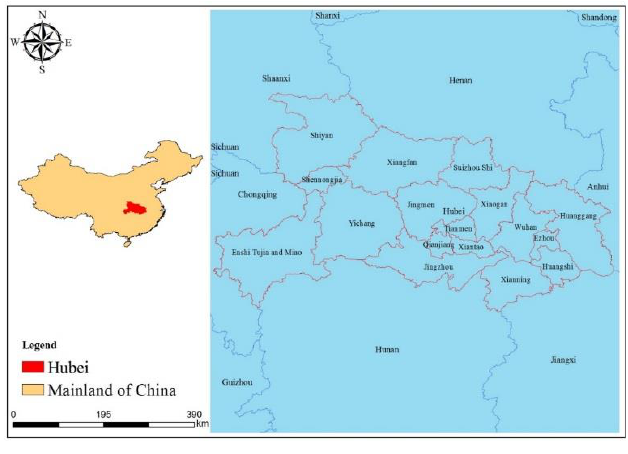
Figure 1: Study area